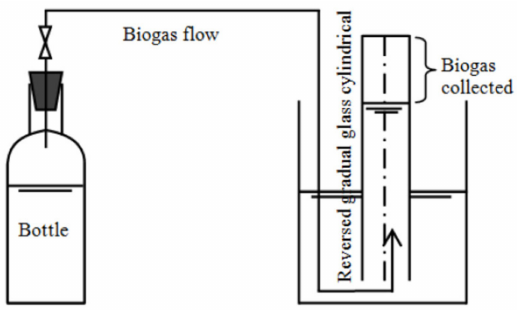
Figure 1. Schematic diagram of liquid displacement